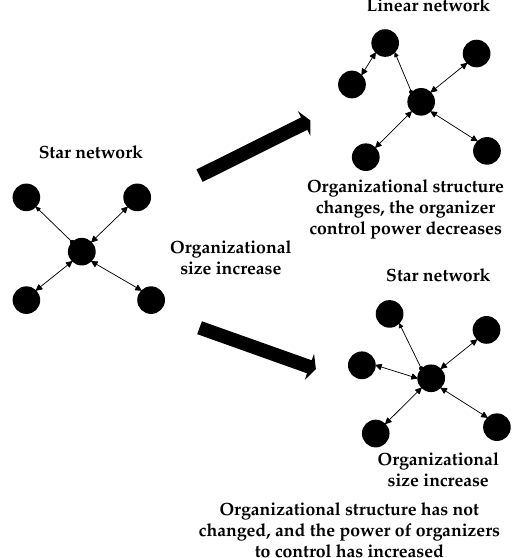
Figure 8. The change of network structure with the increase of organizational scale.